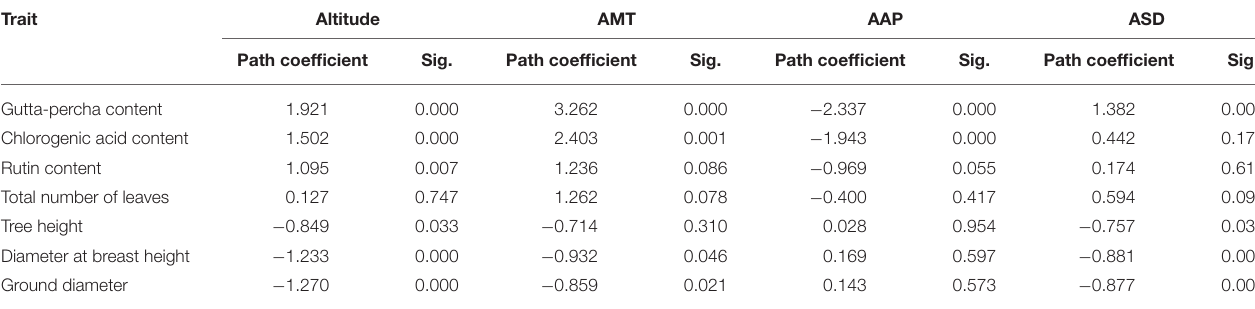
TABLE 8 | Path analysis among traits and environmental factors. Trait Altitude AMT AAP ASD Path coefficient Sig. Path coefficient Sig. Path coefficient Sig. Path coefficient Sig. 1.921 0.000 3.262 0.000 − 2.337